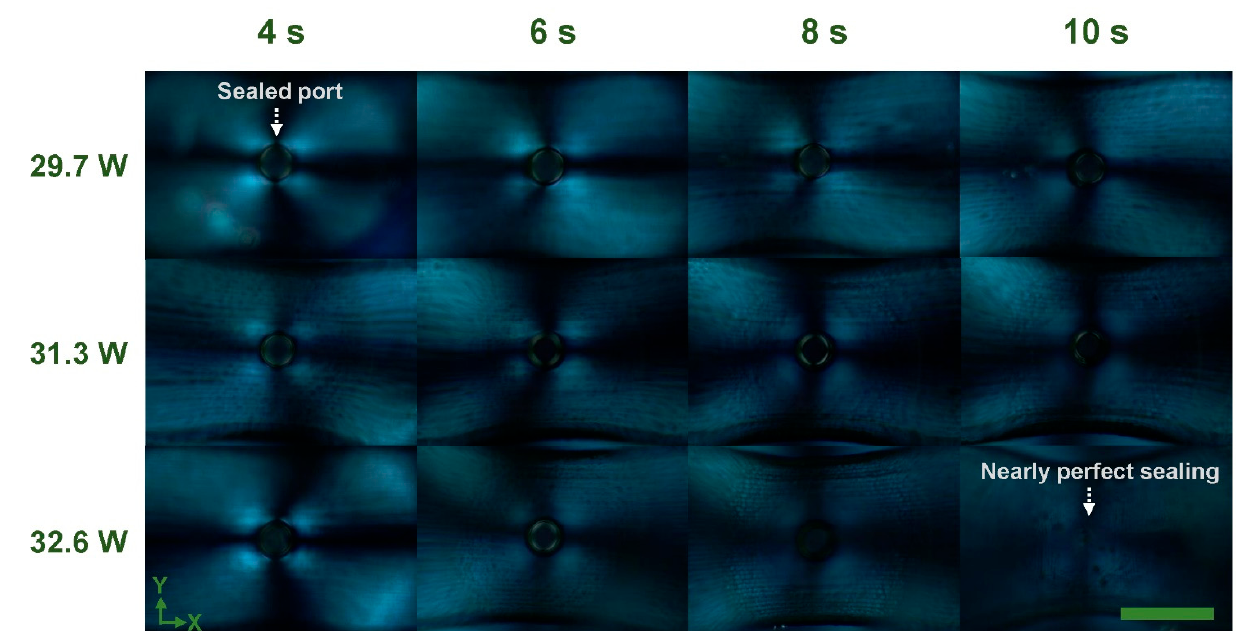
Figure 3. Front-view polarized optical micrographs of a microchannel structure with an extra-access port after defocusing CO 2 laser irradiation at different laser powers (29.7, 31.3, and 32.6 W) and irradiation times (4, 6, 8, 10 s). After CO 2 laser irradiation, the stress distribution of a sealed port exhibits differently depending on irradiation conditions. Scale bar represents 0.5 mm.